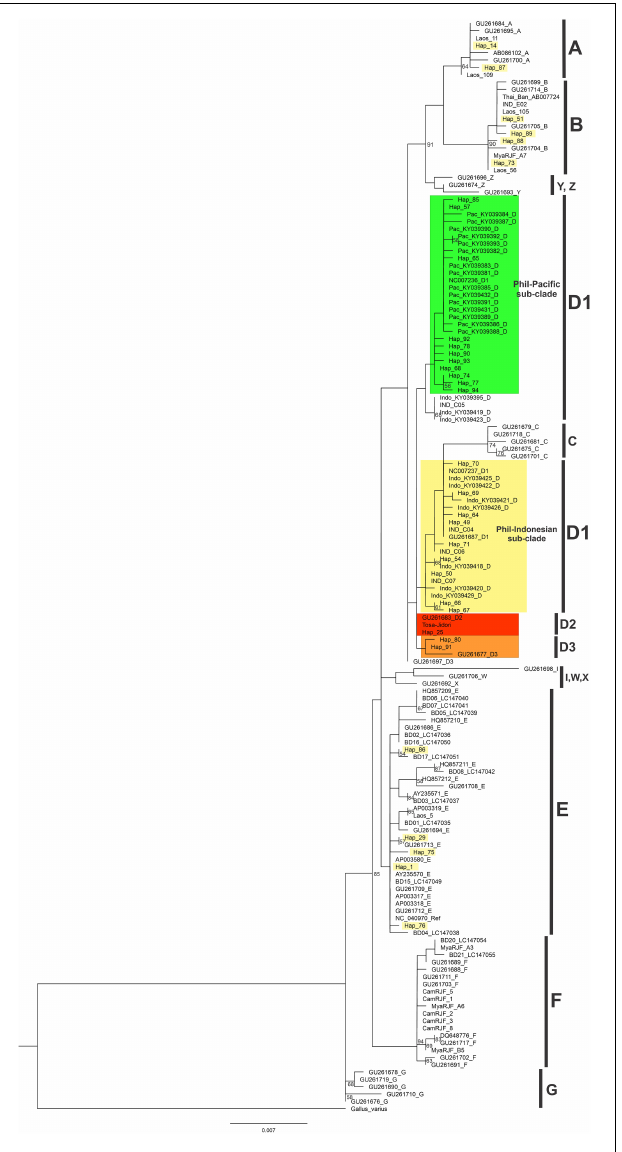
FIGURE 1 | Maximum likelihood phylogenetic tree for complete mtDNA D-loop nucleotide sequences of Philippine chickens. Node labels correspond to bootstrap support values evaluated with 1,000 ultrafast bootstrap replicates in IQ-TREE. The scale bar (0.007) indicates the genetic distance (substitution per site). Bootstrap values under 50% are not